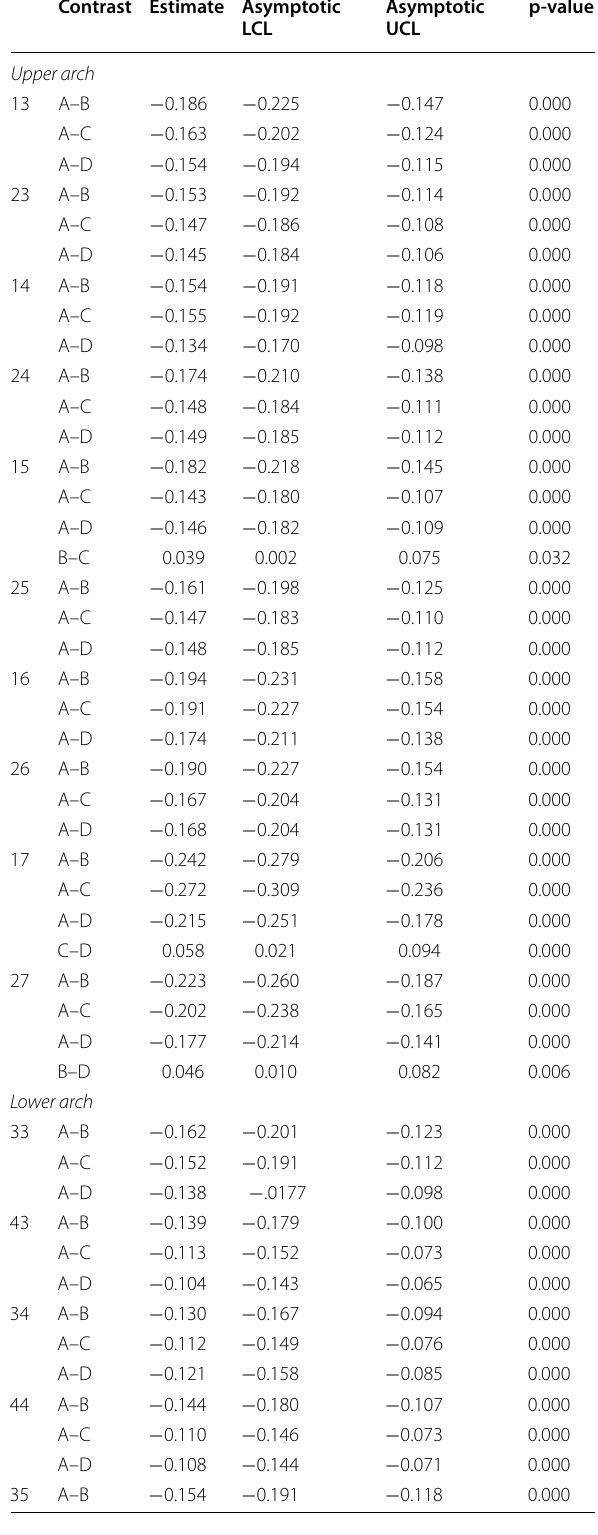
Table 7 Post hoc analysis regarding the statistically significant differences between the units per tooth Contrast Estimate Asymptotic